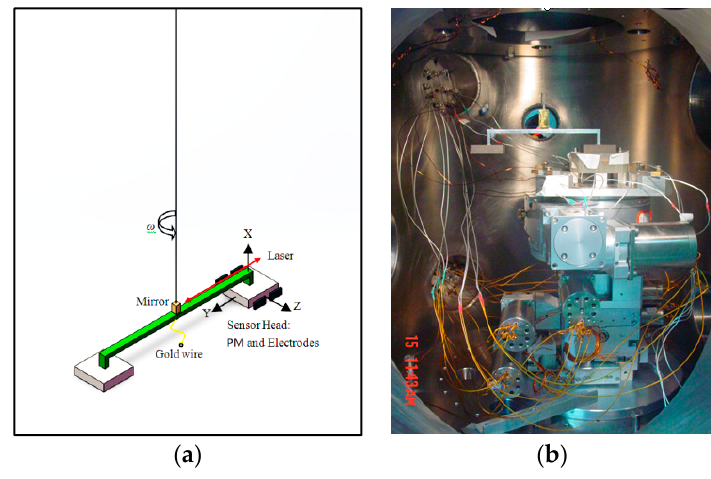
Figure 10. ( a ) Schematic of torsion balance; ( b ) experimental setup of torsion balance in vacuum chamber.